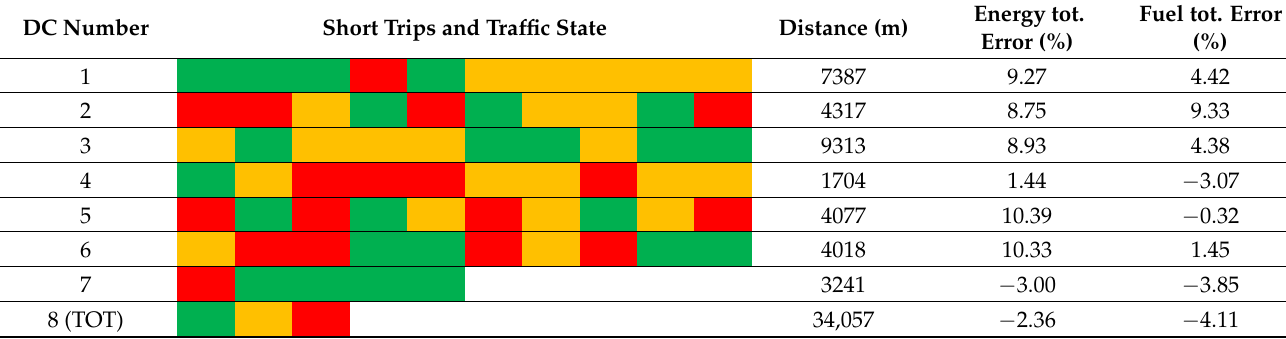
Table 3. Results. Each square is a short trip with a traffic level: red for high, orange for medium, green for low. DC Number Short Trips and Traffic